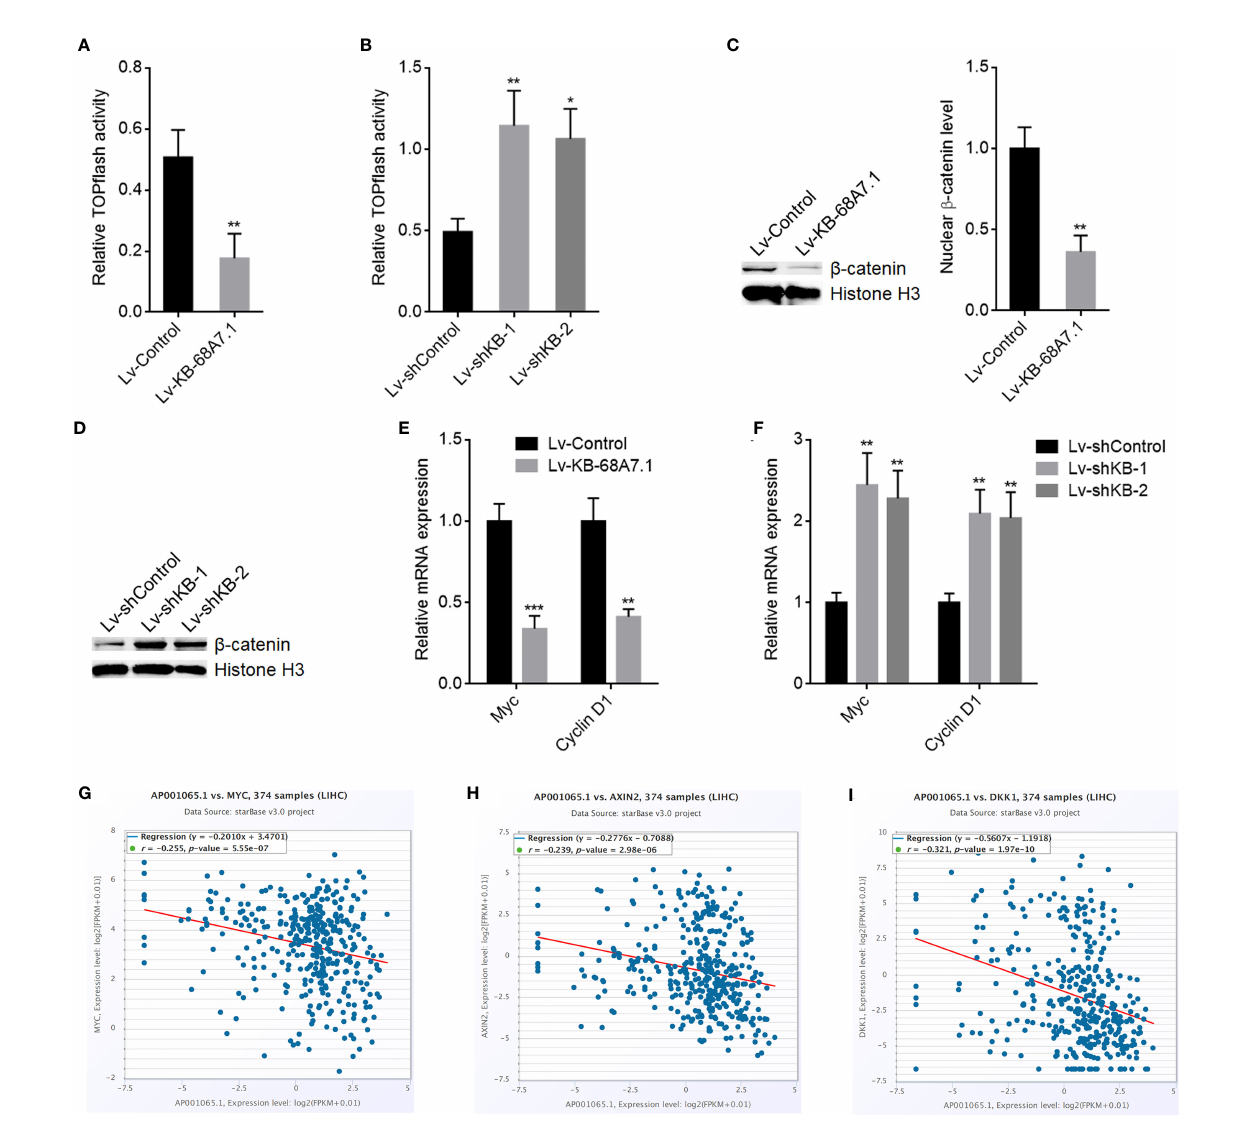
FIGURE 7 | KB-68A7.1 repressed Wnt/ b -catenin signalling. (A) Wnt/ b -catenin reporter TOP fl ash was co-transfected with pRL-TK into SNU-398 cells with KB- 68A7.1 overexpression or control. Luciferase activities were measured 48 h after transfection. Results were shown as the ratio of Fire fl y luciferase activity to Renilla luciferase activity. (B) Wnt/ b -catenin reporter TOP fl ash was co-transfected with pRL-TK into SNU-398 cells with KB-68A7.1 silencing or control. Luciferase activities were measured 48 h after transfection. Results were shown as the ratio of Fire fl y luciferase activity to Renilla luciferase activity. (C) Nuclear b -catenin level in SNU- 398 cells with KB-68A7.1 overexpression or control was measured by Western blot. (D) Nuclear b -catenin level in SNU-398 cells with KB-68A7.1 silencing or control was measured by Western blot. (E) Myc and cyclin D1 expressions in SNU-398 cells with KB-68A7.1 overexpression or control were measured by RT-qPCR. (F) Myc and Cyclin D1 expressions in SNU-398 cells with KB-68A7.1 silencing or control was measured by RT-qPCR. (G – I) The correlations between MYC (G) , AXIN2 (H) , DKK1 (I) , and KB-68A7.1 (AP001065.1) expression in HCC tissues according to TCGA LIHC dataset were analysed by the online in silico tool ENCORI. For Panels (A – F) , results are shown as mean ± SD based on three independent experiments. *p < 0.05, **p < 0.01, ***p < 0.001 by two-tailed unpaired t-test (A, C, E) or one-way ANOVA followed by Dunnett ’ s multiple comparisons test (B, F)